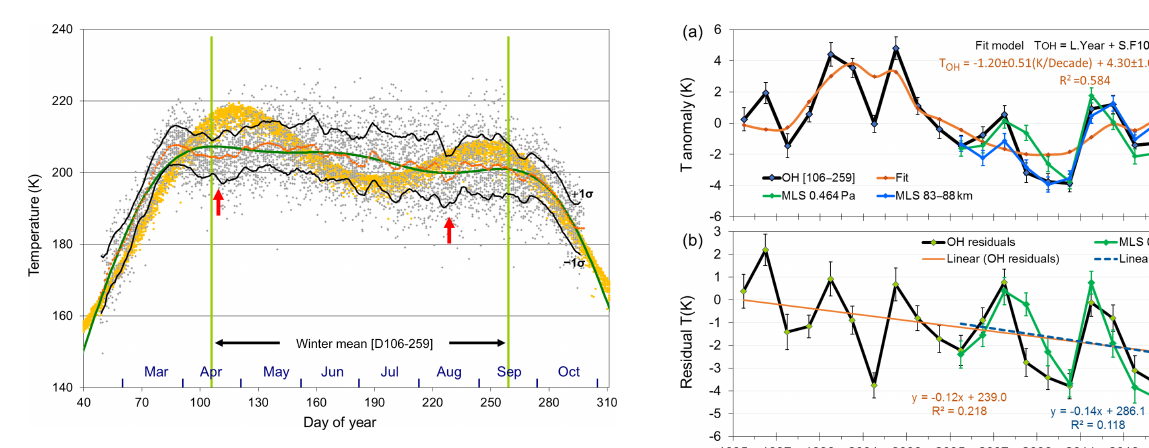
Figure 3. (a) Winter mean (D106-259) temperature anomalies (black line) for Davis station (68 ◦ S, 78 ◦ E) fitted with a linear model containing a solar cycle term (F10.7cm flux) and long- term linear trend (orange line). Fit coefficients are 4 . 30 ± 1 . 02K per 100sfu (95% confidence limits 2.18 to 6.42K per 100sfu) and − 1 . 20 ± 0 . 51K per decade (95% confidence limits − 0 . 14 to − 2 . 26K per decade) and account for 58% of the temperature vari- ability. Also plotted (from 2005) are Aura/MLS temperature anoma- lies derived from the AMJJAS means of all satellite observations within 500km of Davis station. (b) As for (a) , but with the solar cycle component removed to better reveal the long-term trend and quasi-quadrennial oscillation (QQO). OH residuals (black line) are compared with Aura/MLS temperature residuals at the 0.00464hPa level, corrected with the same solar cycle component as used for the Davis OH